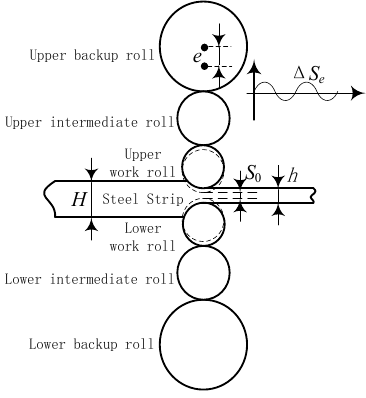
Figure 1. Schematic diagram of rollers in a rolling mill.